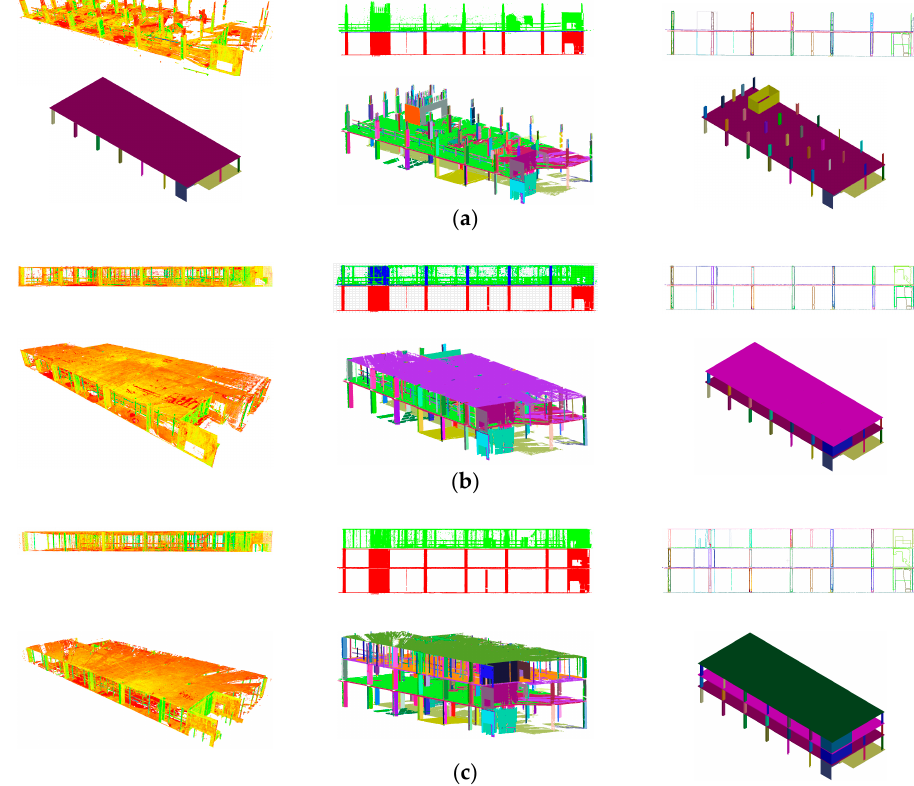
Figure 9. Results of redundant surface removal and column extraction: ( a ) epoch 3: point cloud (top left), as-built model of epoch 2 (bottom left), redundant surface removal (top middle), planar and linear segmentation (bottom middle), side-view of the extracted boundaries of columns (top right), and as-built model of epoch 3 (bottom right); ( b ) epoch 4: point cloud (left), redundant surface removal (top middle), planar and linear segmentation (bottom middle), side-view of the extracted boundaries of columns (top right), and as-built model of epoch 4 (bottom right); and ( c ) epoch 5: point cloud (left), redundant surface removal (top middle), planar and linear segmentation (bottom middle), side-view of the extracted boundaries of columns (top right), and as-built model of epoch 4 (bottom right).